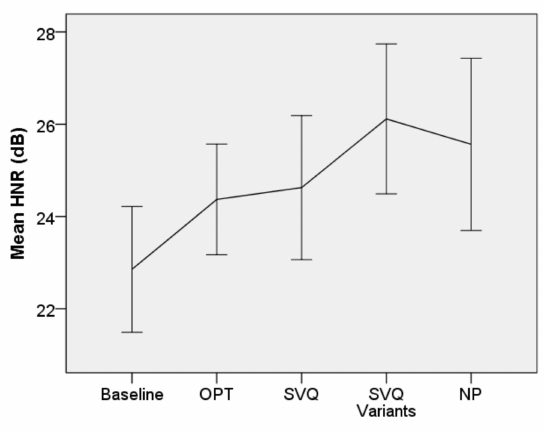
Figure 6. Mean harmonics-to-noise ratio. Error bars indicate 95% CI for the